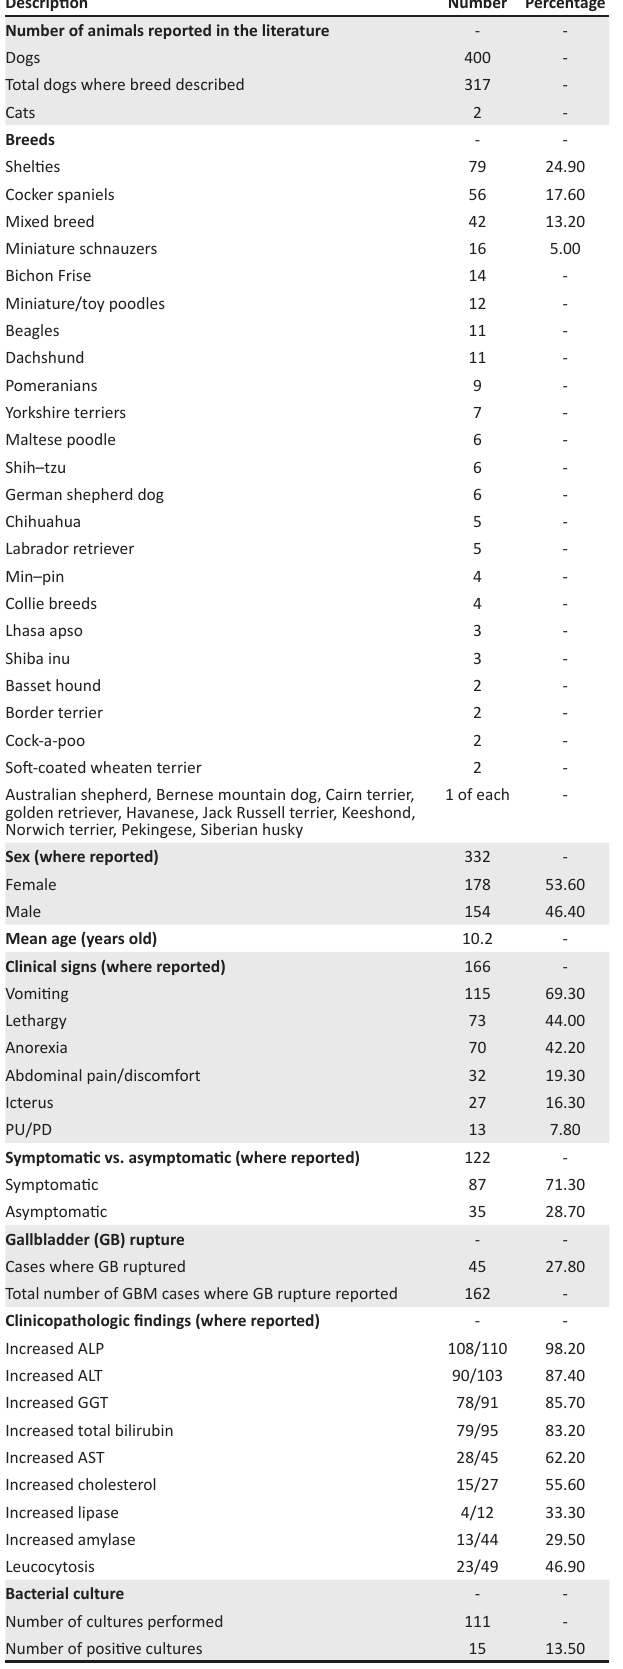
TABLE 1: A summary of the signalment, clinicopathologic changes and bacteriology associated with gallbladder mucocoeles in dogs and cats generated by careful consideration of the mentioned reference